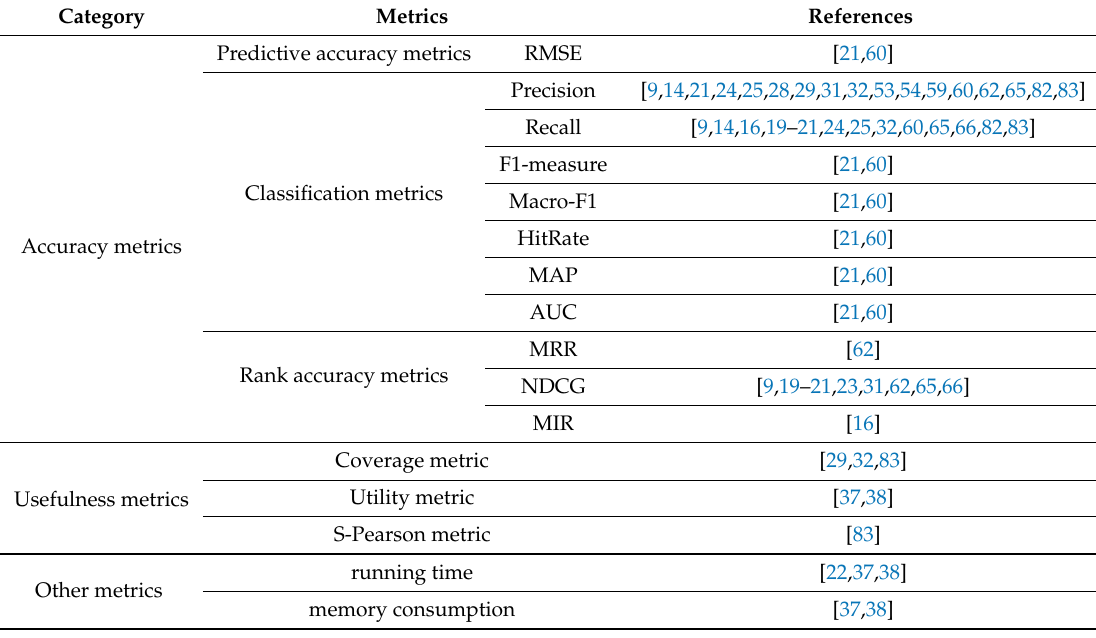
Table 3. Overview of evaluation metrics of the context-aware recommendation in